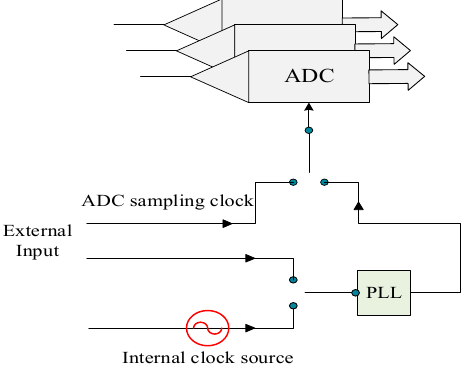
Figure 10. Diagram of clock source.